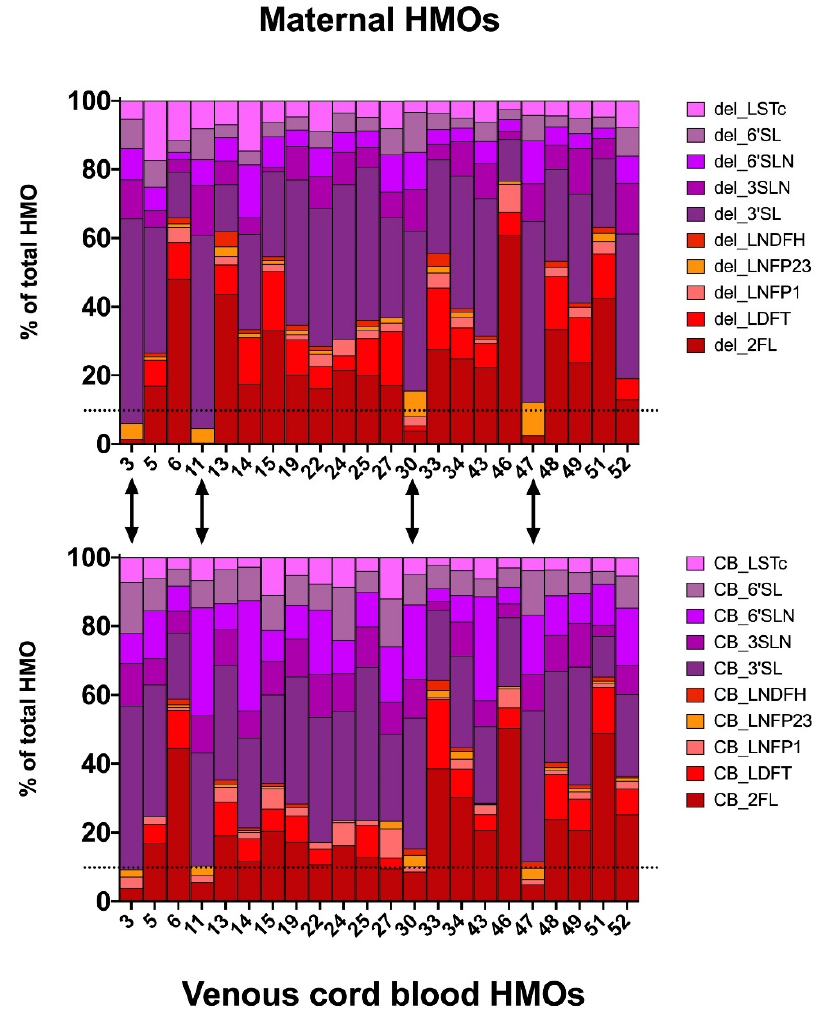
Figure 2. Relative HMO concentrations in maternal serum ( upper panel ) and cord blood serum ( lower panel ) allows for assignment of the secretor status. Stacked bar plots showing the percentage of total HMOs in 22 mother–infant pairs. 2 ′ FL percentage below 10% indicates secretor-negative status and assigned status matches between maternal and cord blood samples. Dotted line marks the 10% of 2 ′ FL cut-off used to discriminate between secretor positive and negative individuals. Arrows depict the four secretor-negative sample pairs (#3, #11, #30, and #47).